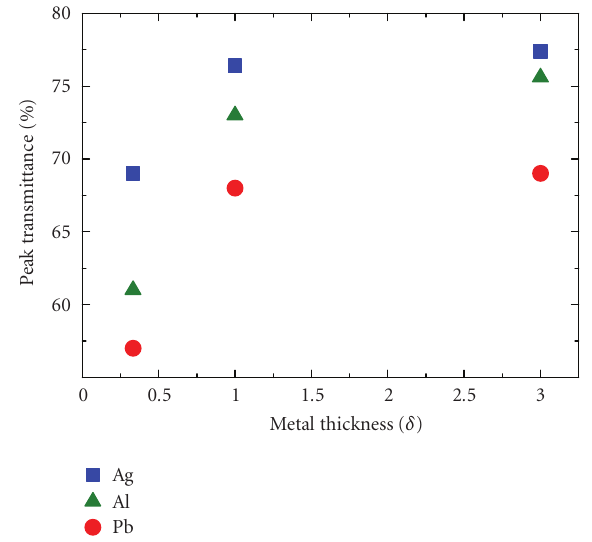
Figure 5: Peak transmittance at the 0.55 [ ± 1,0] THz metal-Si mode for arrays made from Ag, Al, and Pb with di ff erent metal thick- nesses. The arrays are metal on silicon with rectangular holes of dimensions 100 μ m × 80 μ